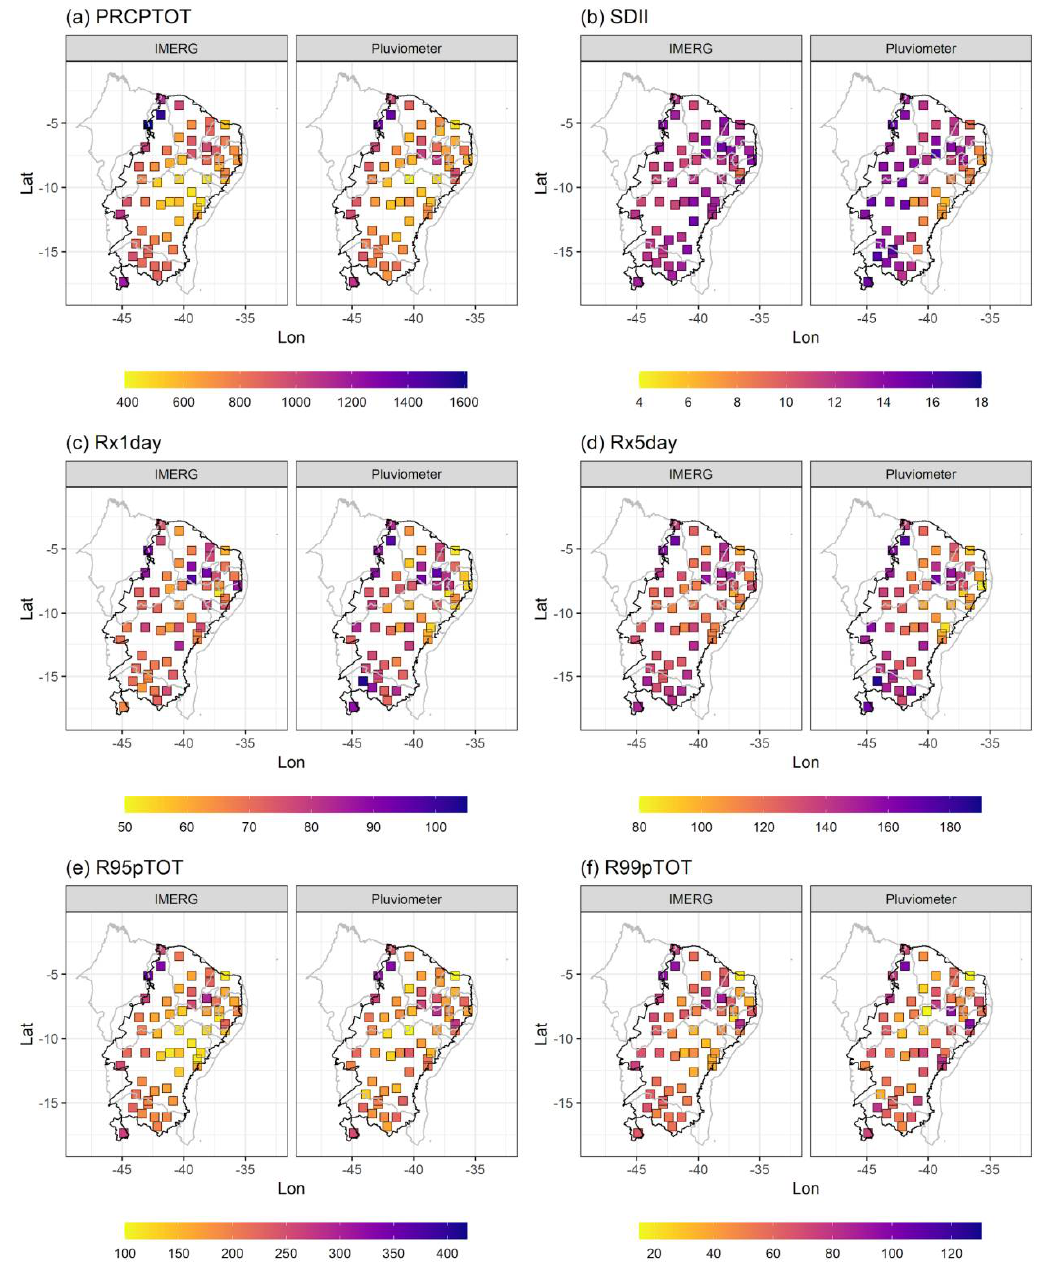
Figure 2. Intensity indices (mm) referring to the 56 IMERG grid points and rain gauges over 21 years